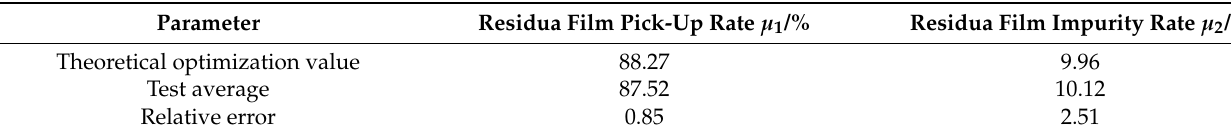
Table 5. A comparison between the optimum theoretical and test results.